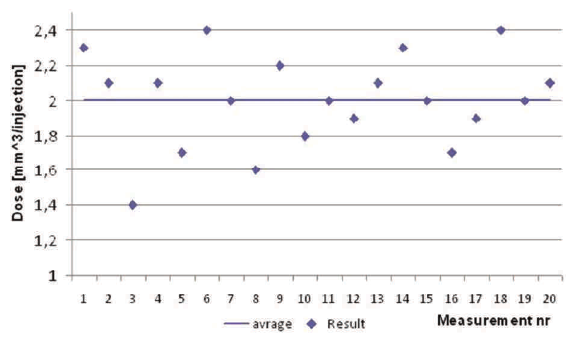
Fig. 4. Outlines of VE test before test modification